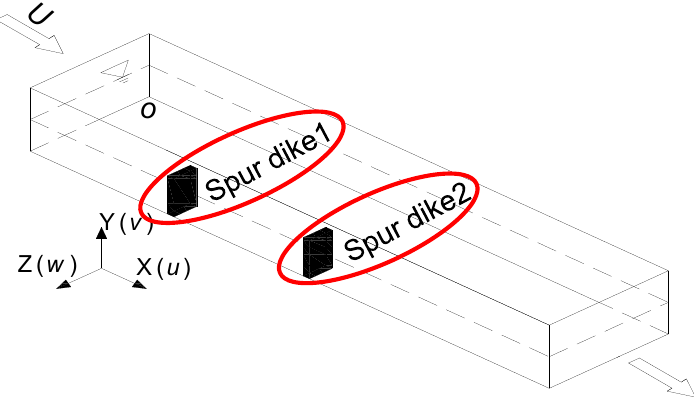
Figure 2. Non-submerged twin spur dikes with ipsilateral and orthogonal layout sketch.